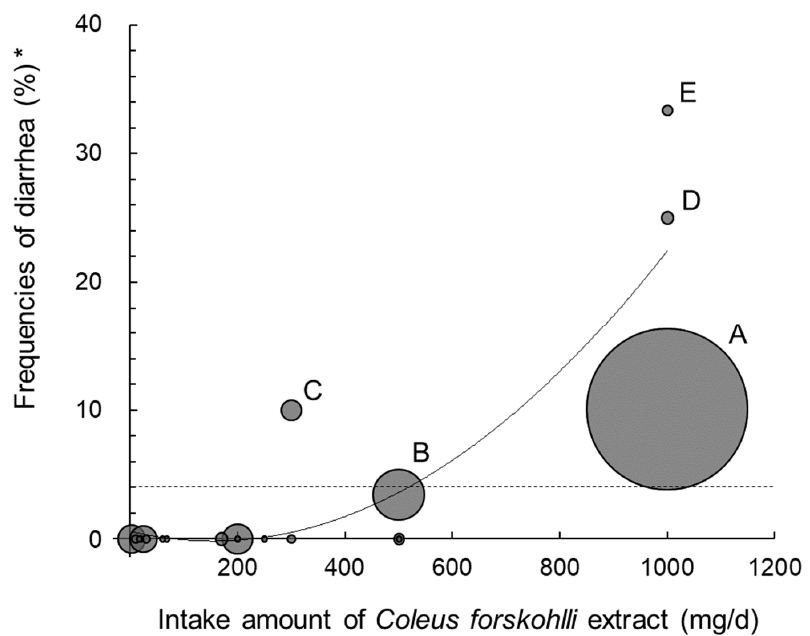
Figure 2. The relationship between the suggested amount of Coleus forskohlii extract per day and the frequencies of diarrhea ( n = 61). Each circle represents a product pointed at the cross-point of the amount of Coleus forskohlii extract and the frequencies of diarrhea. The size of the circles indicates the number of the total users of each product. Six out of the 27 products were excluded due to the absence of information on the amount of the extract. The equation of the fitted curve is as follows: y = 3×10 -5 × 2 − 0.0098x + 0.5862 (R² = 0.7568). The dotted line shows the frequency of diarrhea caused by the